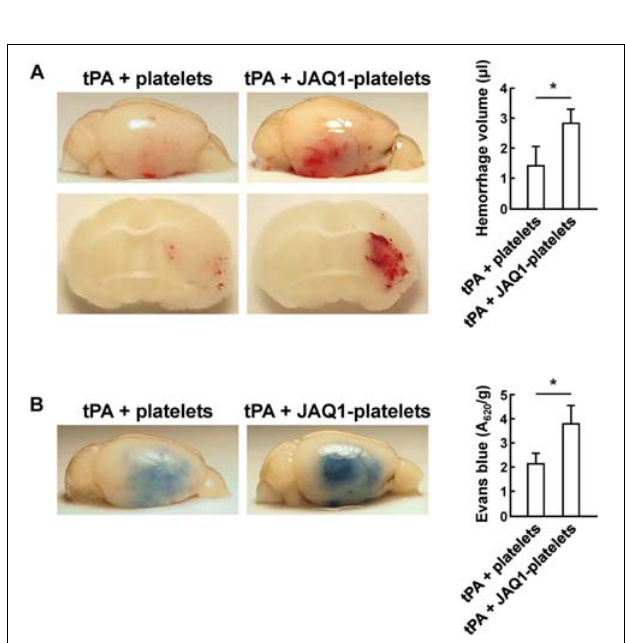
FIGURE 5 | Platelets reduced tPA-induced hemorrhage and BBB disruption in a GPVI-dependent manner. (A,B) Representative images and quantification of brain hemorrhage (A) and Evans blue dye extravasation (B) 24 h after cerebral ischemia in mice treated with tPA + platelets, or tPA + JAQ1-platelets. Immediately after tPA treatment, mice were transfused with platelets or anti-GPVI antibody (JAQ1)-pretreated platelets. n = 8 per group. Values are mean ± SD. ∗ P <